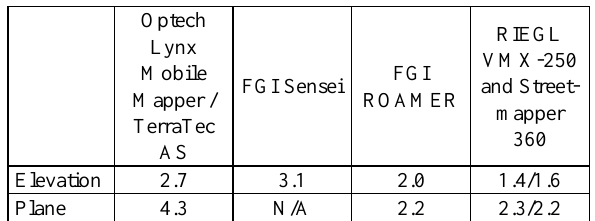
Table 3. Elevation and planimetric accuracies (STD) in cm for tested MLS